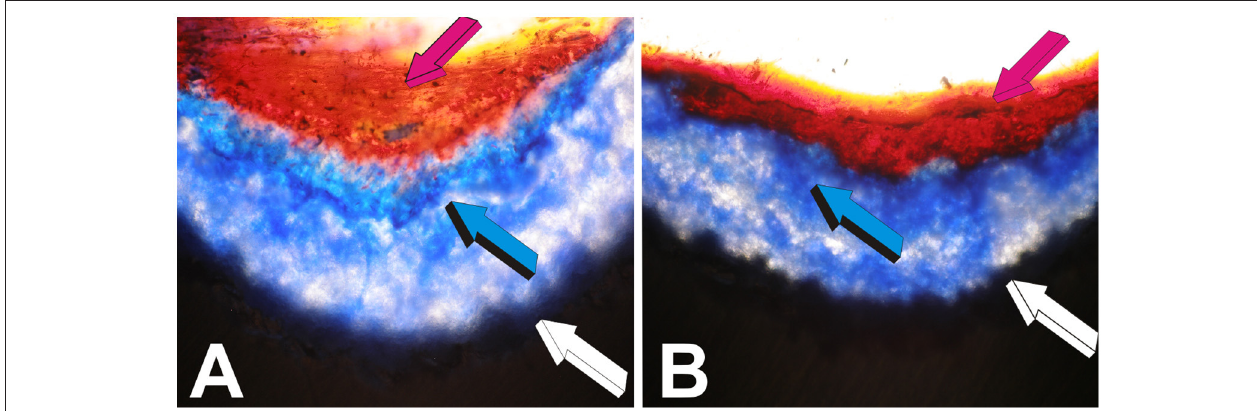
FIGURE 9 | The crux of the problem of bone tissue engineering and regenerative medicine in clinical context. Can we engineer an activated bioreactor that spontaneously, and/or intrinsically initiate the ripple-like cascade of bone differentiation by induction, without the exogenous application of the osteogenic soluble molecular signals of the transforming growth factor- β (TGF- β ) supergene family? (Ripamonti, 2003) and when implanted in human patient synthesize per se “ Bone: formation by autoinduction ?” ( Urist, 1965). The undecalcified images presented in (A,B) show that the above is possible, that hydroxyapatite coated titanium geometric constructs per se initiate the spontaneous induction of bone formation in primate models ( Ripamonti et al., 2012a) and without the exogenous application of the osteogenic soluble molecular signals of the TGF- β supergene family. (A) High power view of a concavity of hydroxyapatite-coated titanium construct (white arrow) harvested from the rectus abdominis muscle of Papio ursinus . Light blue arrow indicates the induction of mineralized newly formed bone (darker blue) surfaced by an osteoid seam (magenta arrow) surfacing the mineralized bone. (B) In another inductive concavity identical morphological patterns of induction with newly formed mineralized bone (light blue arrow) surfaced by a large osteoid seam. Undecalcified sections cut at 30 µ m using the Exakt diamond saw grinding and polishing equipment ( Ripamonti et al.,